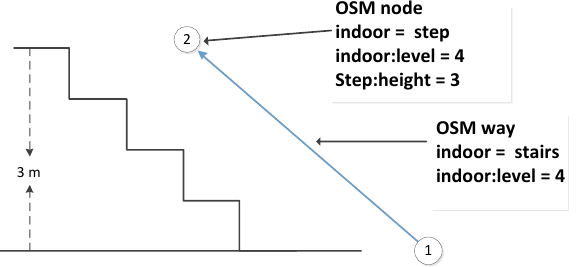
Figure 5. An example using OSM ways to model stairs.